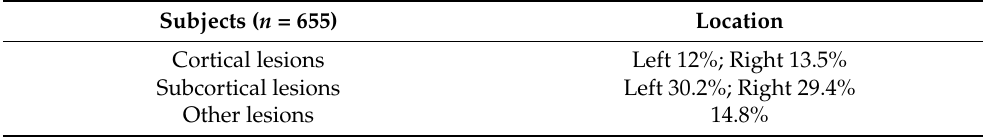
Table 1. Data characteristics for training dataset.